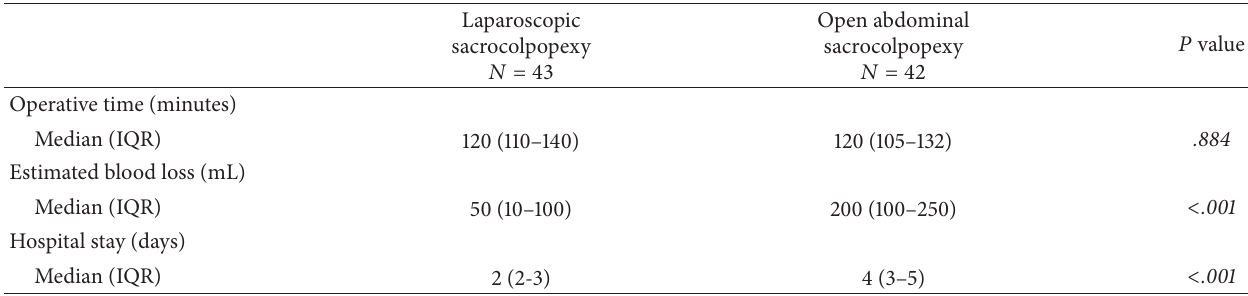
Table 3: Perioperative data